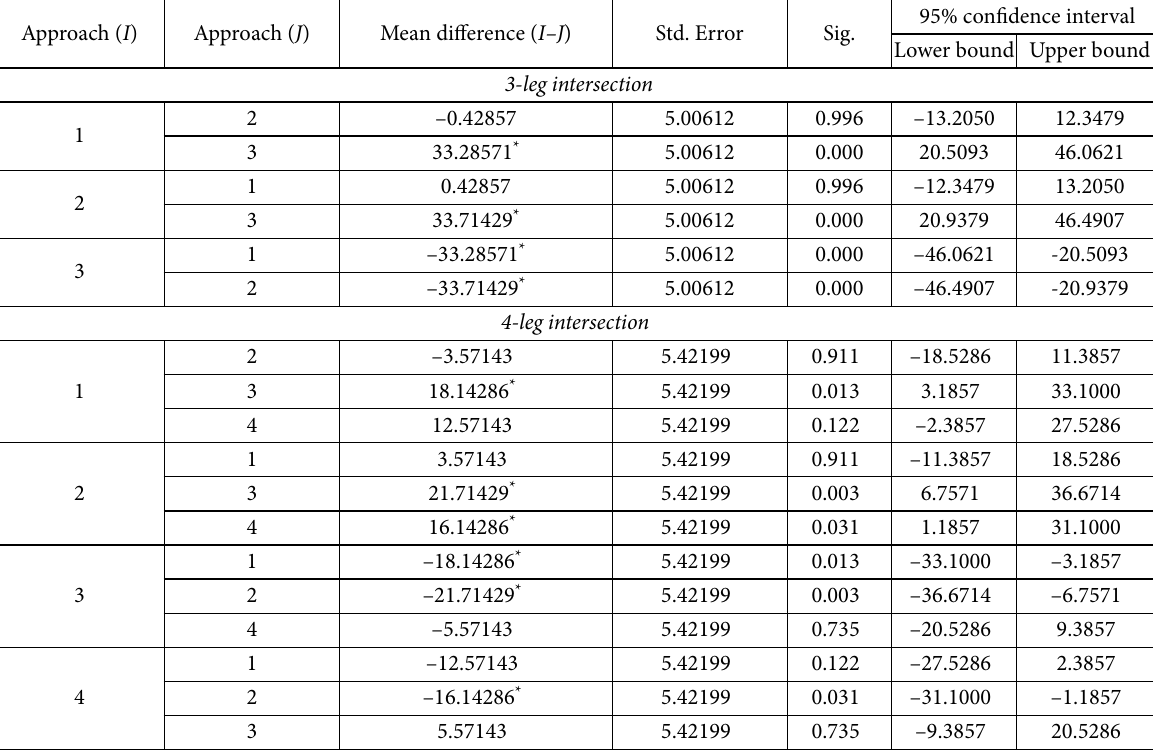
Table 4. PostHoc Tukey test for different approaches per